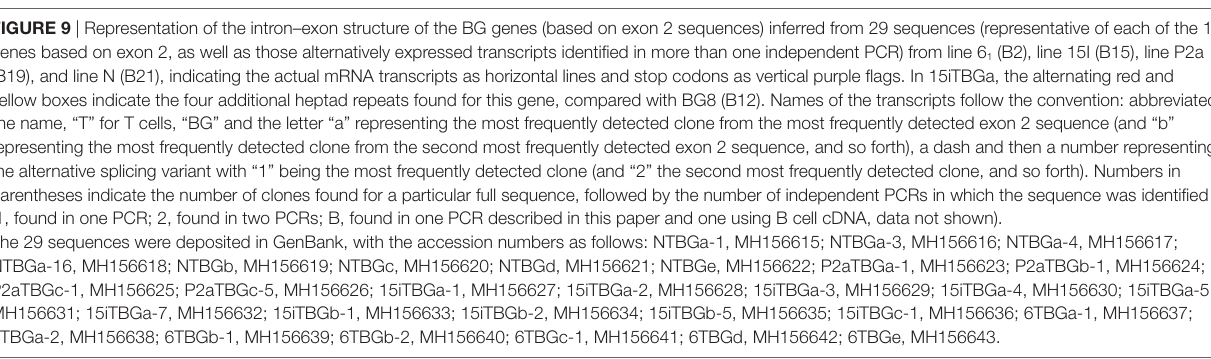
FigUre 9 | Representation of the intron–exon structure of the BG genes (based on exon 2 sequences) inferred from 29 sequences (representative of each of the 16 genes based on exon 2, as well as those alternatively expressed transcripts identified in more than one independent PCR) from line 6 1 (B2), line 15I (B15), line P2a (B19), and line N (B21), indicating the actual mRNA transcripts as horizontal lines and stop codons as vertical purple flags. In 15iTBGa, the alternating red and yellow boxes indicate the four additional heptad repeats found for this gene, compared with BG8 (B12). Names of the transcripts follow the convention: abbreviated line name, “T” for T cells, “BG” and the letter “a” representing the most frequently detected clone from the most frequently detected exon 2 sequence (and “b” representing the most frequently detected clone from the second most frequently detected exon 2 sequence, and so forth), a dash and then a number representing the alternative splicing variant with “1” being the most frequently detected clone (and “2” the second most frequently detected clone, and so forth). Numbers in parentheses indicate the number of clones found for a particular full sequence, followed by the number of independent PCRs in which the sequence was identified (1, found in one PCR; 2, found in two PCRs; B, found in one PCR described in this paper and one using B cell cDNA, data not shown). The 29 sequences were deposited in GenBank, with the accession numbers as follows: NTBGa-1, MH156615; NTBGa-3, MH156616; NTBGa-4, MH156617; NTBGa-16, MH156618; NTBGb, MH156619; NTBGc, MH156620; NTBGd, MH156621; NTBGe, MH156622; P2aTBGa-1, MH156623; P2aTBGb-1, MH156624; P2aTBGc-1, MH156625; P2aTBGc-5, MH156626; 15iTBGa-1, MH156627; 15iTBGa-2, MH156628; 15iTBGa-3, MH156629; 15iTBGa-4, MH156630; 15iTBGa-5, MH156631; 15iTBGa-7, MH156632; 15iTBGb-1, MH156633; 15iTBGb-2, MH156634; 15iTBGb-5, MH156635; 15iTBGc-1, MH156636; 6TBGa-1, MH156637; 6TBGa-2, MH156638; 6TBGb-1, MH156639; 6TBGb-2, MH156640; 6TBGc-1, MH156641; 6TBGd, MH156642; 6TBGe,